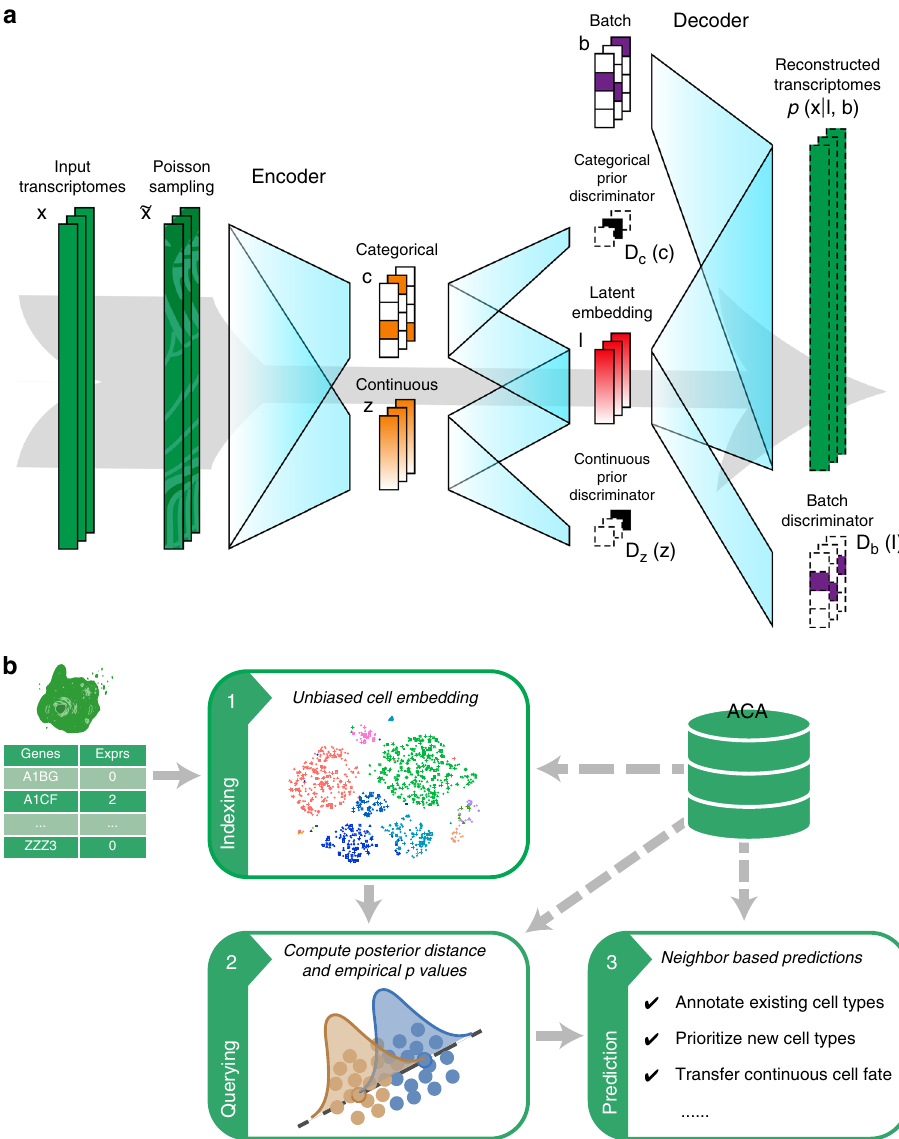
Fig. 1 Cell BLAST model and work fl ow. a Structure of the generative model used by Cell BLAST. b Overall Cell BLAST work fl